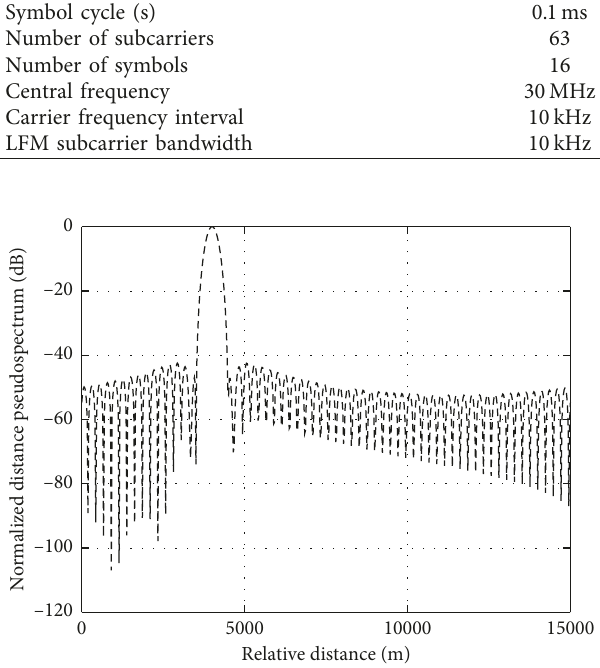
Figure 3: Pseudospectrum associated with the target distance based on the OFDM-LFM framework.